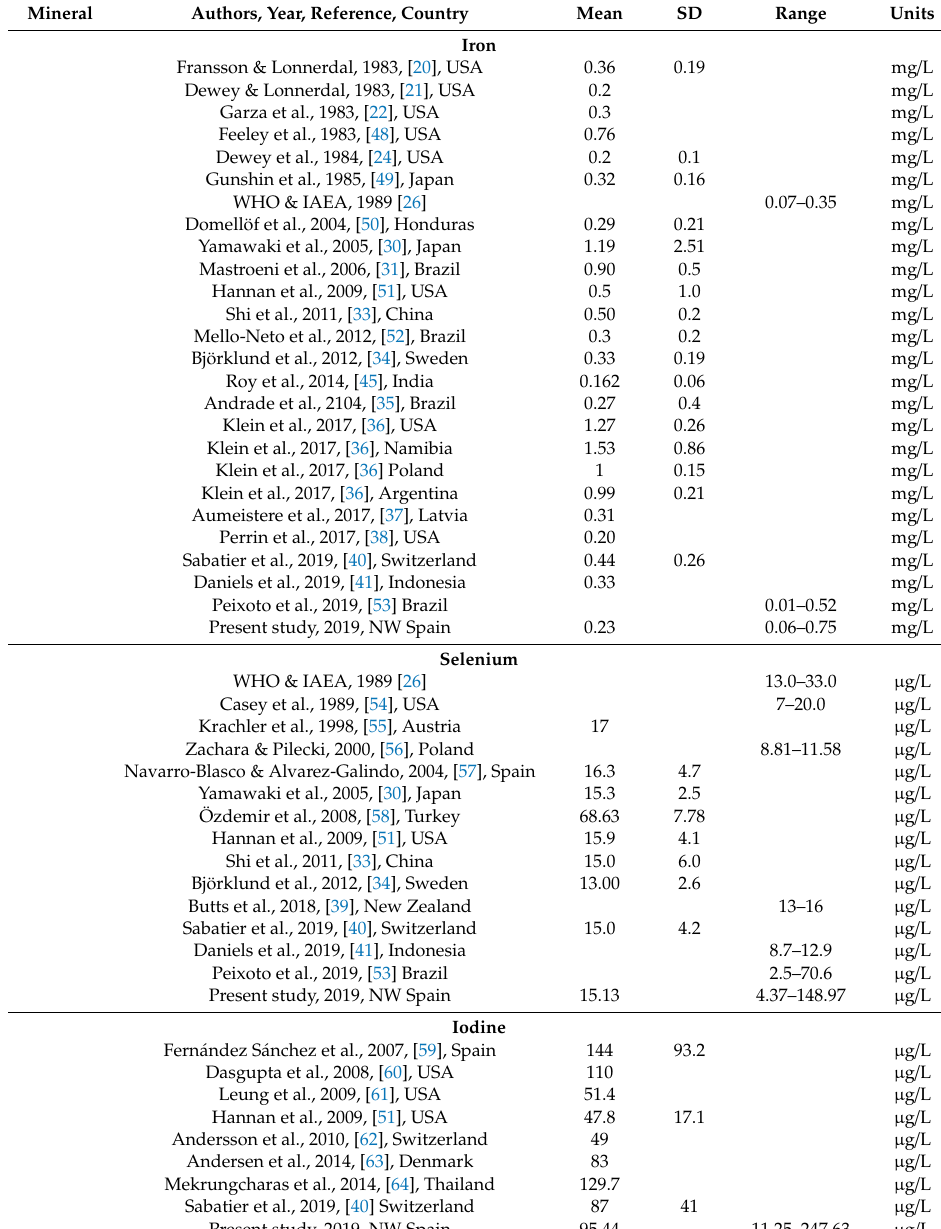
Table 5. Trace element concentration [18] reported in mature human milk in di ff erent